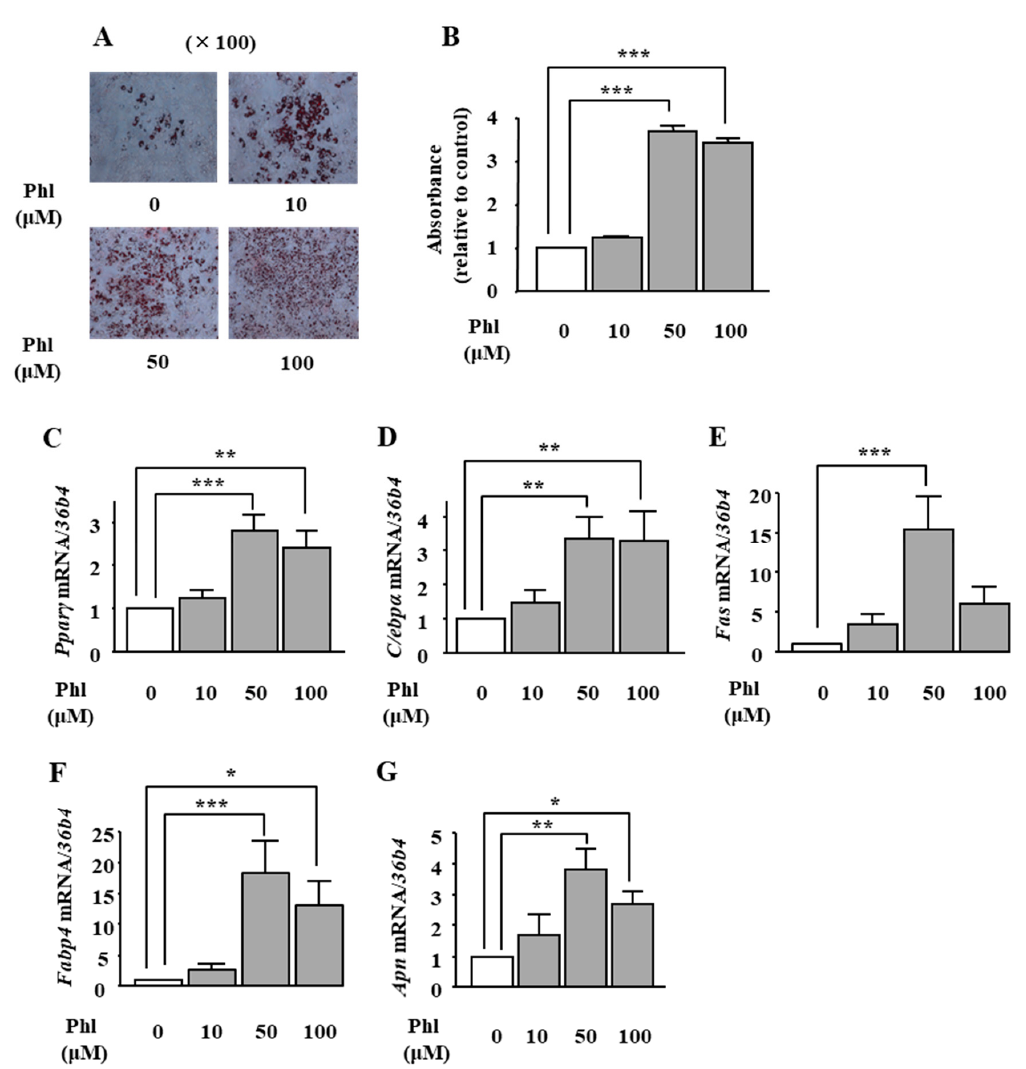
Figure 1. The effects of phloretin on adipocyte differentiation in ST2 cells. ( A , B ) After reaching confluency, ST2 cells were incubated in adipogenic medium with phloretin (0, 10, 50, and 100 µM), and oil red O staining was performed at day 8. The results are representative of at least seven different experiments. The quantification results are expressed as mean ± SE ( n = 6); *** p < 0.001. ( C – G ) After reaching confluency, the cells were incubated in adipogenic medium. The mRNA expression of adipogenic differentiation markers ( Ppar γ , C/ebp α , Fas , Fabp4 , and Apn ) was examined by real-time PCR at day 4. The results are expressed as mean ± SE ( n ≥ 5); * p < 0.05, ** p < 0.01, *** p < 0.001. Phl: phloretin.